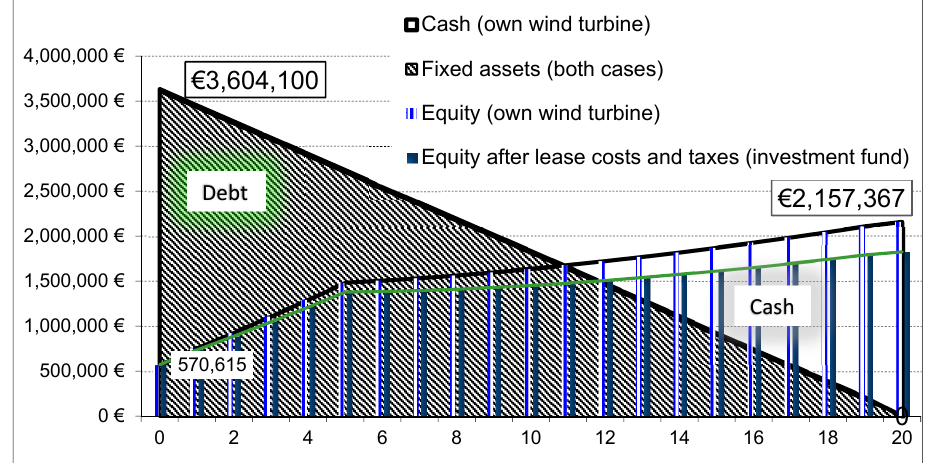
Figure 4. Amount of investment at the beginning, necessary equity capital and development of fixed assets, and cash surplus for a wind turbine depending on the investor (farmer or external investor, example of lease share amounting to 5.5% of the electricity revenue).